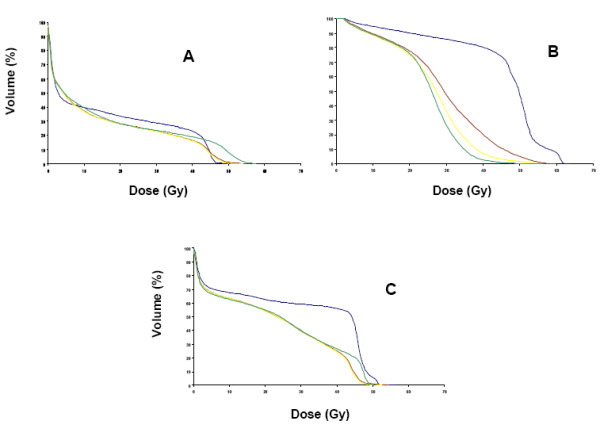
(3A), Mean Dose-Volume Histograms (DVH) for iliac crests of N0-1 group. Arm A, blue; arm B, brown; arm C, yellow; arm D, green; (3B), Mean Dose-Volume Histograms (DVH) for genitalia/perineum of N0-1 group. Arm A, blue; arm B, brown; arm C, yellow; arm D, green; (3C), Mean Dose-Volume Histograms (DVH) for small bowel of N0-1 group. Arm A, blue; arm B, brown; arm C, yellow; arm D, green.